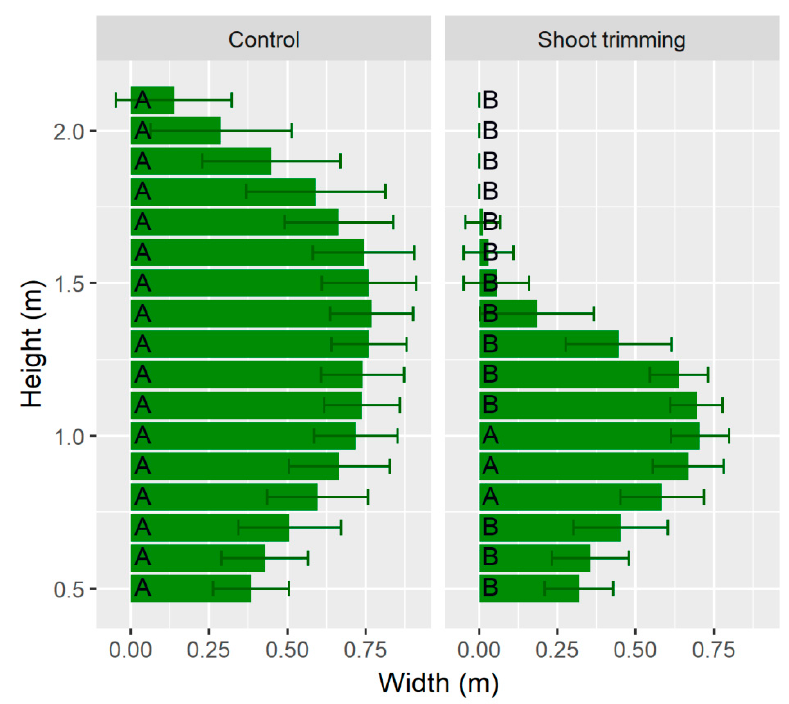
Figure 10. Vine width at different heights after the shoot trimming experiment at the Ausejo-2 vineyard (error bars represent the standard deviation). For each height, different letters indicate significant differences among treatments at p = 0.05 by a Student’s T-test. Remote Sens. 2020 , 12 , x FOR PEER REVIEW